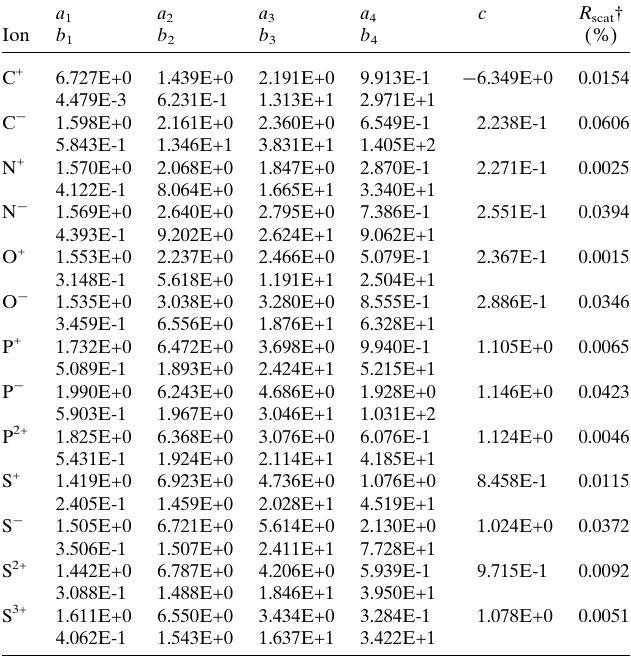
Table 2 Parameterization of X-ray scattering factors of ions for the four Gaussians plus a constant